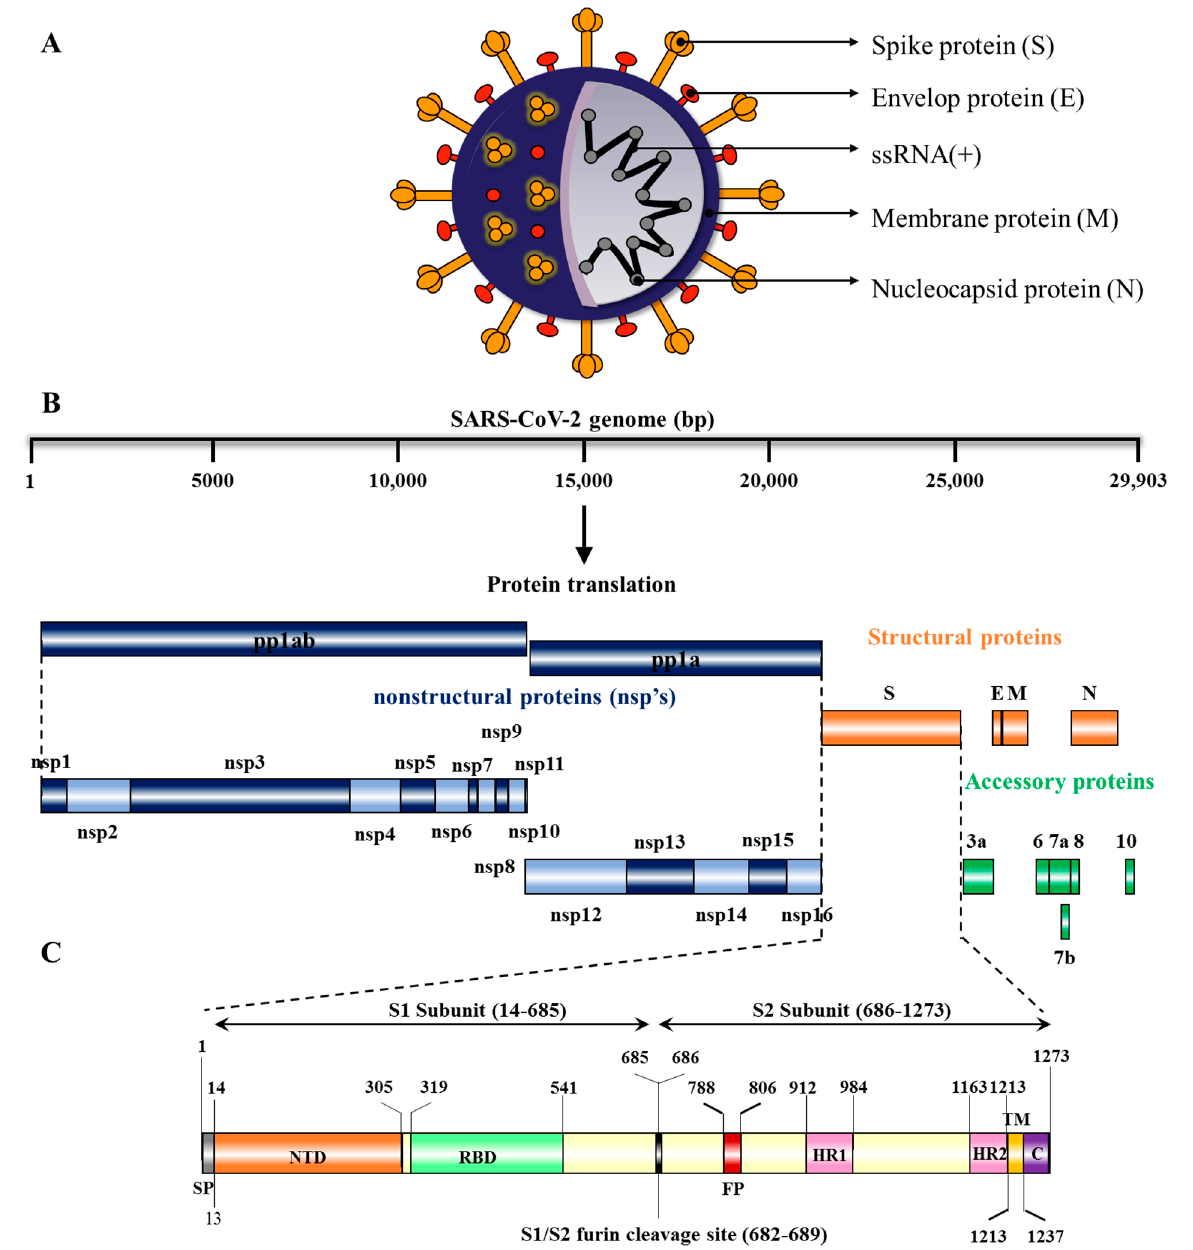
Figure 1. Genomic Organization and Structural Features of surface glycoprotein of SARS-CoV-2: ( A ) Structure of SARS-CoV-2 : The schematic depicts the structural features of SARS-CoV-2 virus particle, which contains a single-stranded RNA, S-glycoprotein, and other structural proteins that include envelope (E), membrane (M), and nucleocapsid (N) proteins. ( B ) Schematic representation of SARS-CoV-2 . proteins: Genome of SARS-CoV-2 consists of approximately 29,903 nucleotides, with ORF-1a and ORF-1b, which are translated to polyprotein 1a (pp1a) and 1ab (pp1ab), respectively. Four genes encoding for structural proteins such as spike (S), envelop (E), membrane (M), and nucleocapsid (N). Accessory proteins (ORF3a, 6, 7a, 7b, 8, and 10) are distributed among structural proteins. ( C ) Structure of SARS-CoV-2 Surface glycoprotein (S): The surface glycoprotein (S protein) is made up of 1273 amino acids, including N-terminal signal peptide (SP), S1 subunit, and S2 subunit. The S1 subunit contains an N-terminal domain (NTD) and a receptor binding domain (RBD), while the S2 subunit is composed of the fusion peptide (FP), heptapeptide repeat sequence 1 (HR1), HR2, TM domain, and cytoplasm domain